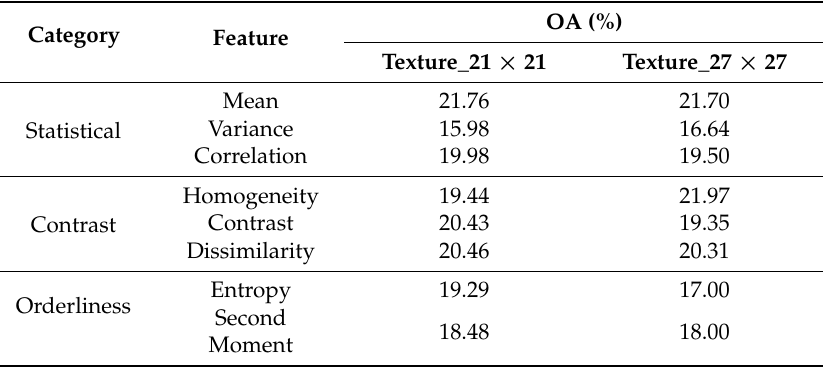
Table 3. Overall Accuracies of the single features classified by the Minimum Distance algorithm (texture images with window size of 21 and 27).